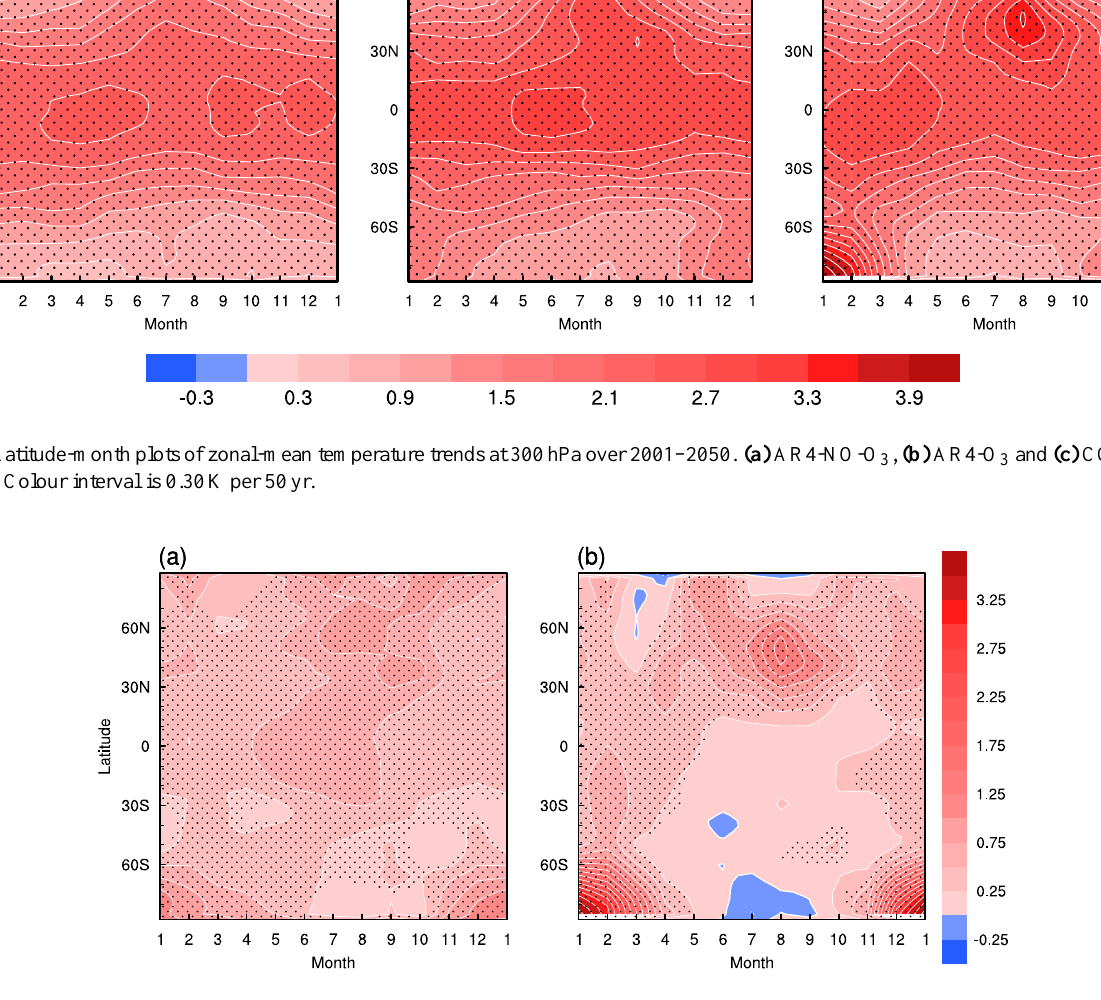
Fig. 8. Latitude-month plots of zonal-mean temperature trend differences at 300hPa over 2001–2050. (a) Difference between AR4-O 3 and AR4-NO-O 3 models, and (b) difference between CCMVal-1 and AR4-NO-O 3 models. Colour interval is 0.25K per 50 years, pink: positive, and blue: